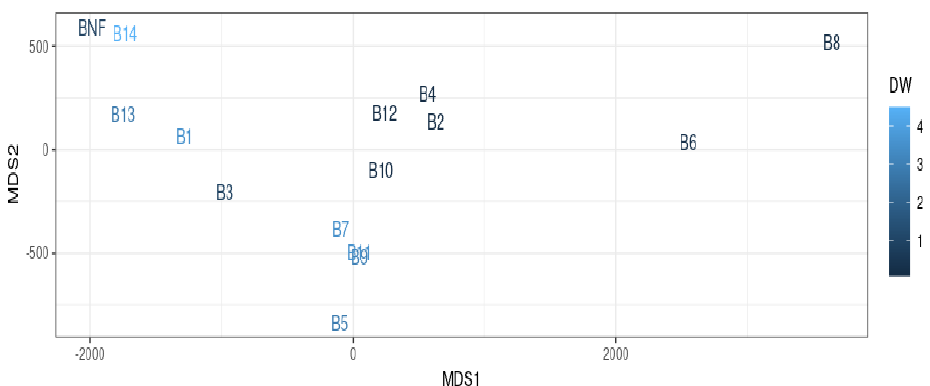
Figure 4. The NMDS graph was used to represent the original position of the dry weight and chemical growing medium composition in multidimensional space as accurately as possible using a reduced number of dimensions. In this ordination, the closer the two points, the more similar the corresponding samples are concerning the variables that made the NMDS plot. DW = dry weight.